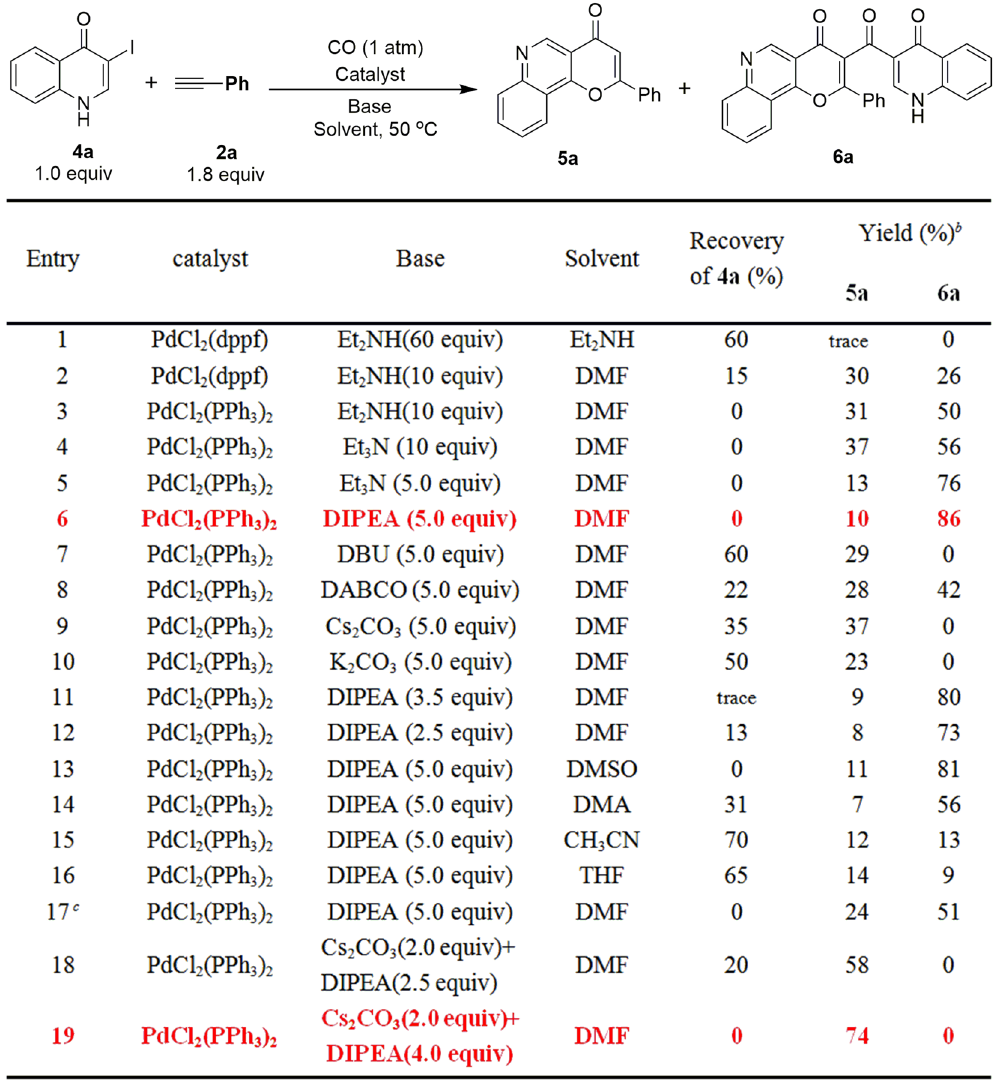
Figure 4. Optimization of the reaction conditions for the selective synthesis of 5a or 6a . a Reaction condition (unless otherwise noted): 4a (0.2 mmol), 2a (0.36 mmol), catalyst (5 mol%), Solvent (1 mL), base, CO (1 atm), stirred at 50 °C for about 14 h. b isolated yield. c Using 1 atm N 2 and Mo(CO) 6 instead of 1 atm